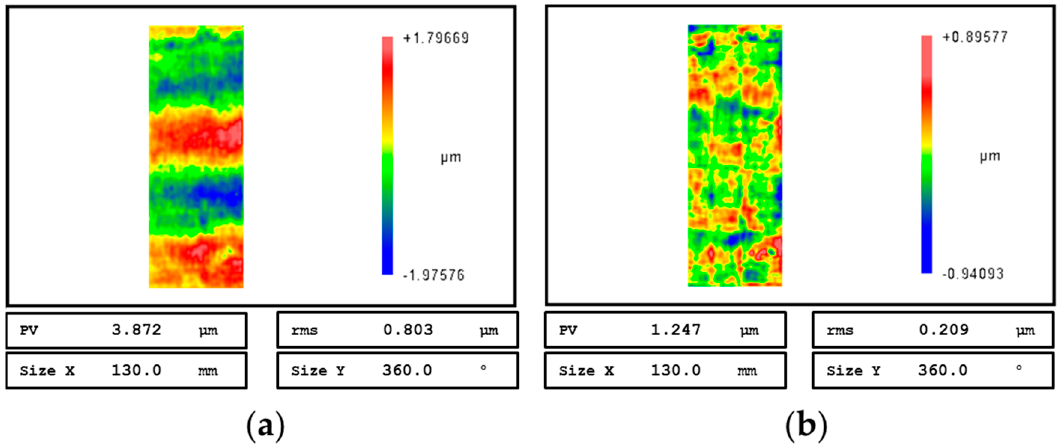
Figure 13. Roundness error surfaces before and after figuring: ( a ) The initial roundness surface error; ( b ) the roundness surface error after figuring process.